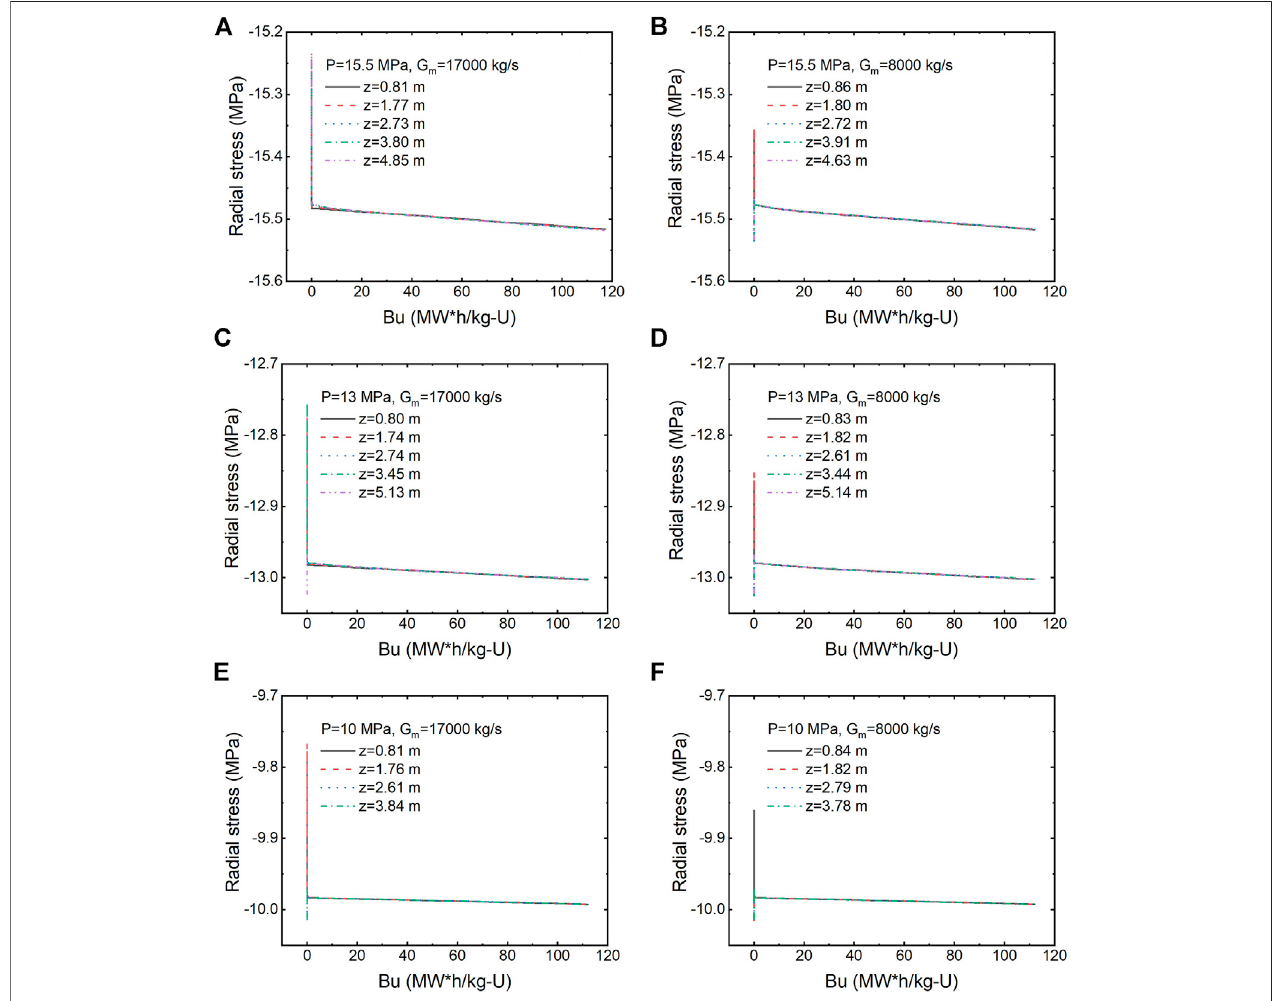
FIGURE 16 | Evolution of radial stress of UO 2 fuel with burnup under different coolant pressures and mass fl uxes.